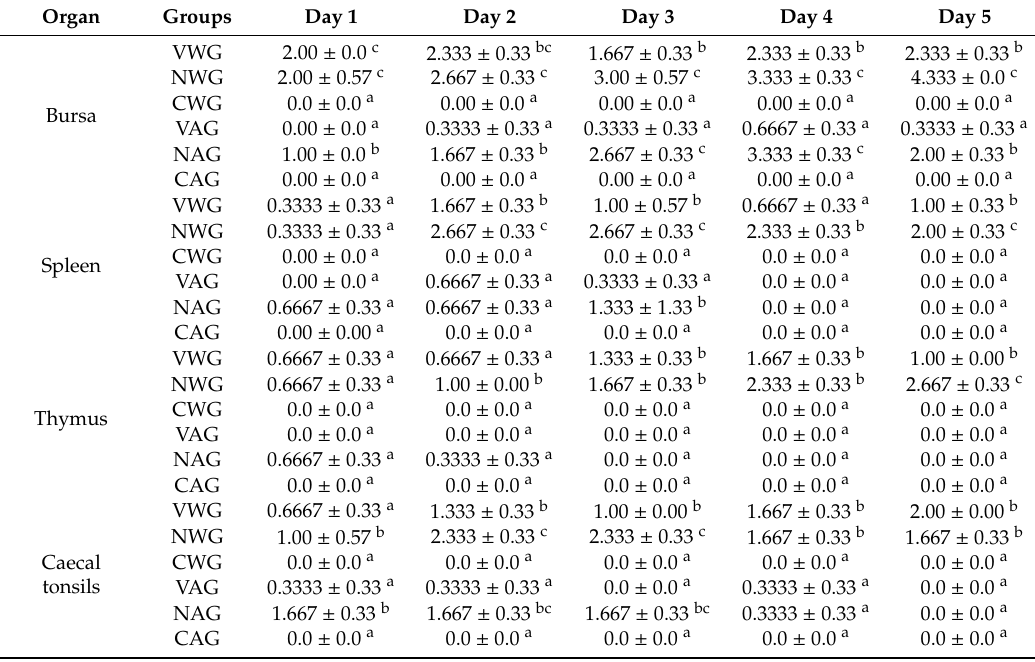
Table 3. Depicting the histopathological lesion scores (Mean ± SE) in various lymphoid organs in di ff erent groups at di ff erent intervals of